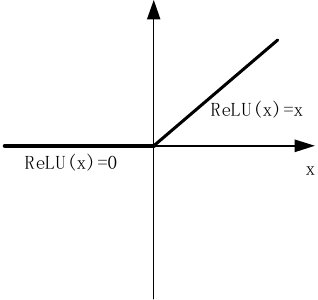
Figure 3. Schematic diagram of the ReLU function.